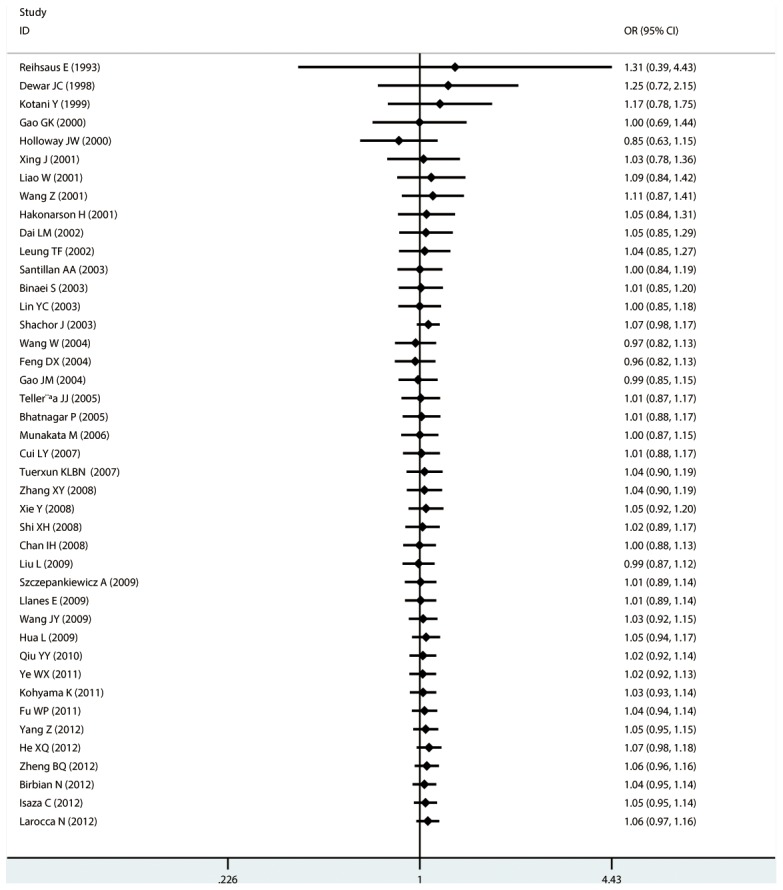
Forest plots of cumulative meta-analysis of Arg16Gly (rs1042713) in association with asthma by published year under dominant model comparison.